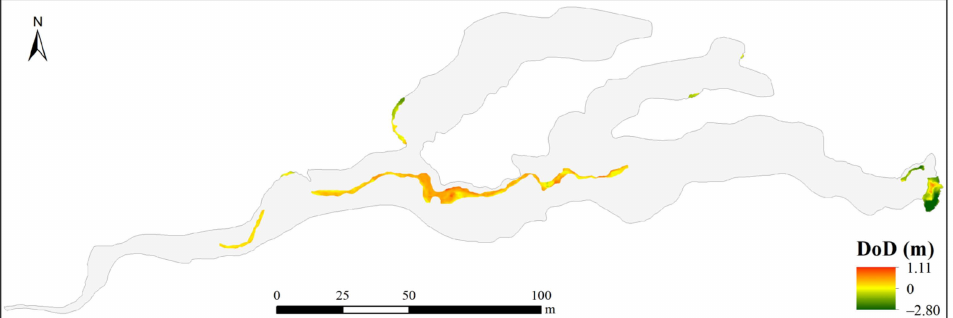
Figure 10. DoD map of the gully (elevation in 2019–elevation in 2015).